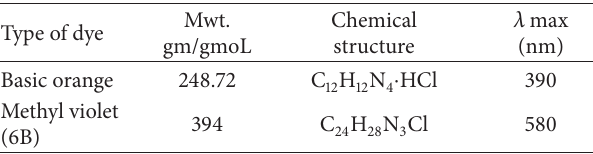
Table 1: Characteristics of applied dyes used in the experiments. Type of dye